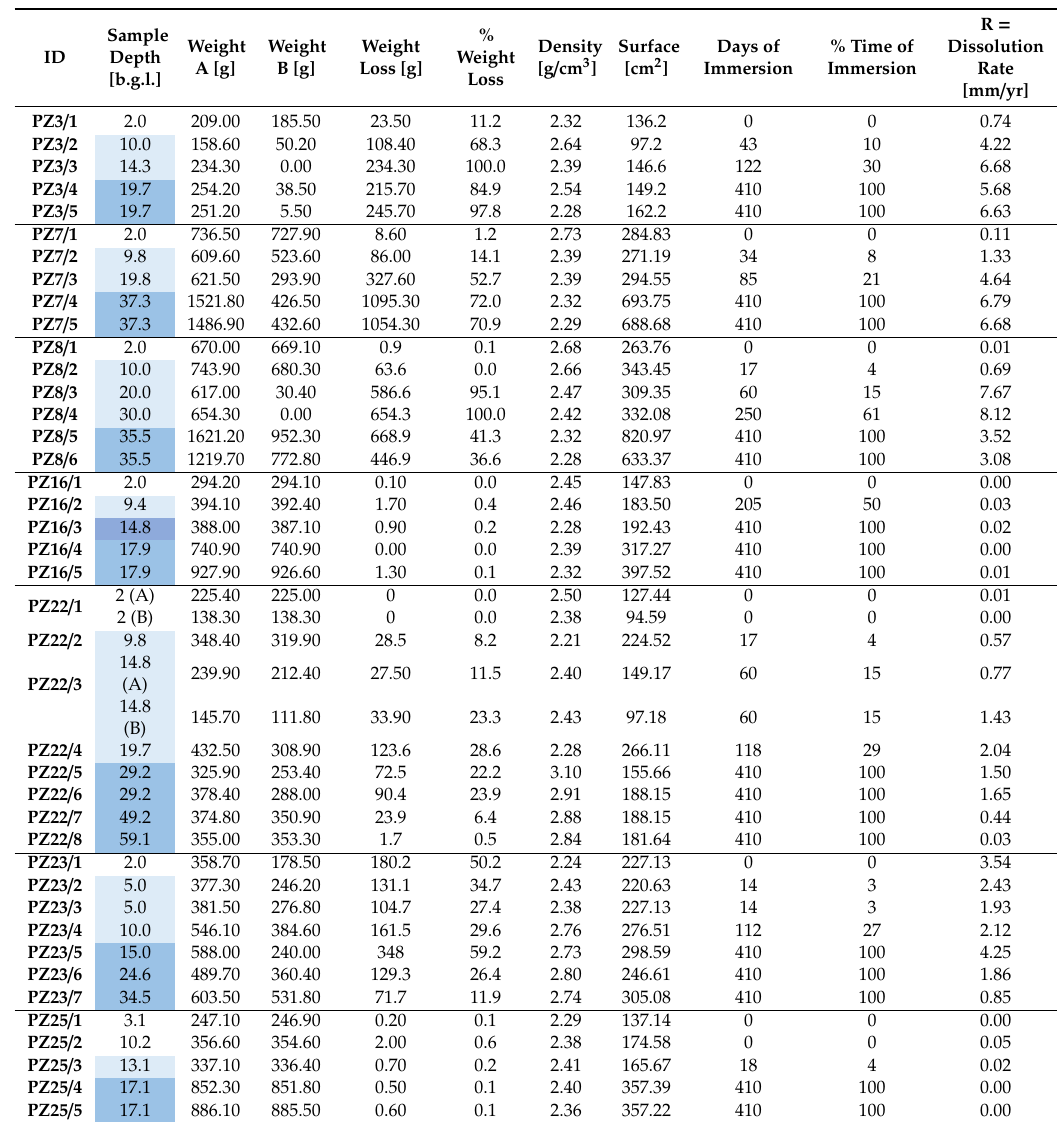
Table 1. Sample depth represents the depth at which the samples were installed: with no colour, the rock samples which always remained in the dry zone. In pale blue the samples which remained in the vadose zone, in dark blue the samples which remained always immerse in the phreatic zone within the whole experimental time. For each sample the weight pre-experiment (A), post-experiment (B), the weight loss and the percentage of weight loss were calculated, as well as their density (measured by using the volume di ff erence). After the surface measurement (geometrical computation realised pre-installation), according to [47], the dissolution rate was